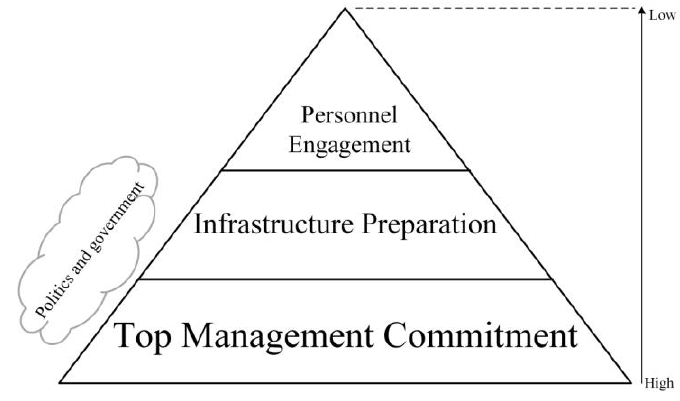
Figure 4. Levels of priority in addressing the EA development